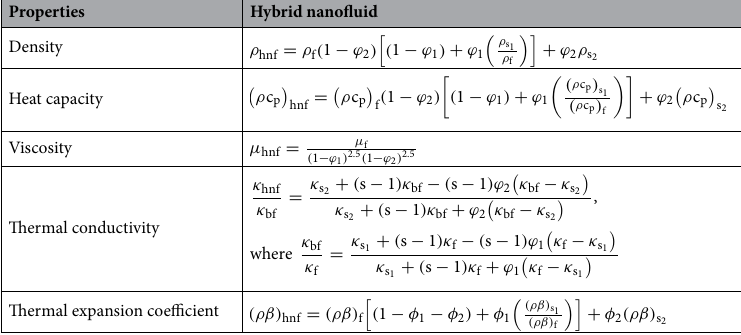
Table 3. Expressions for thermophysical characteristics of hybrid nanofluid.